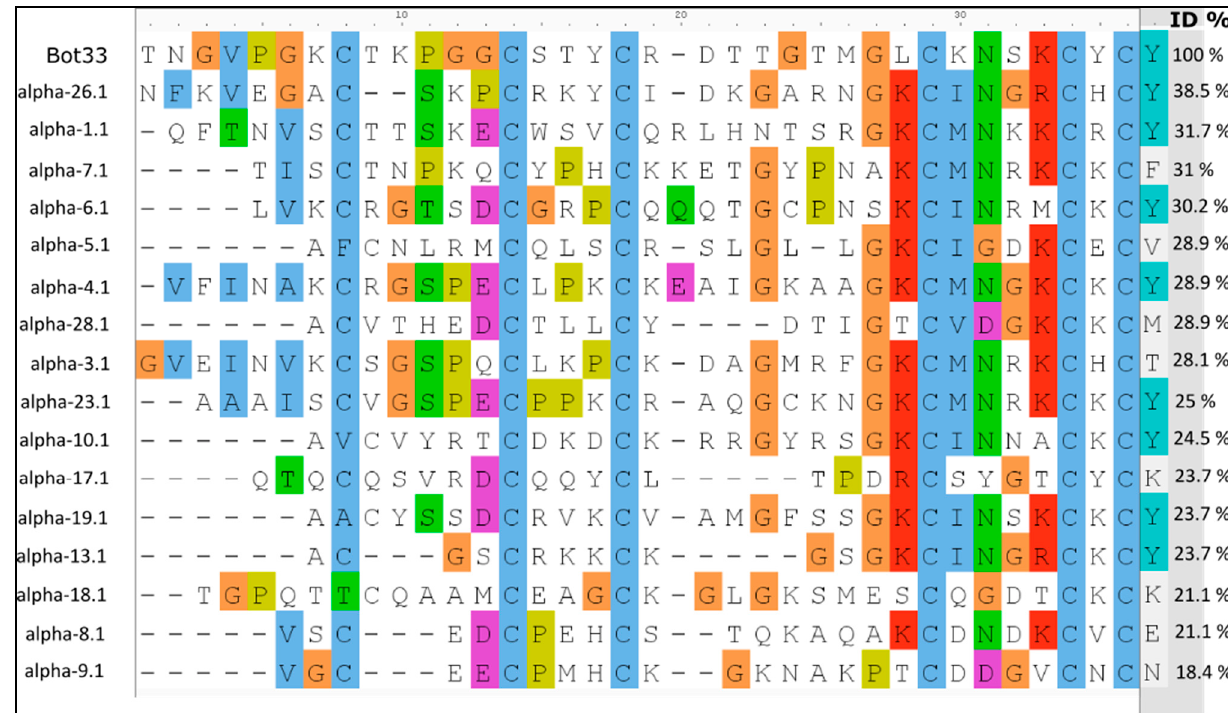
Figure 2. Sequence alignment. Alignment of Bot33 with the first members of each alpha-KTx subfamily described up to date. Cysteine residues are highlighted in red. The numbers next to each toxin’s name represent the percentage of identity (ID) with Bot33.